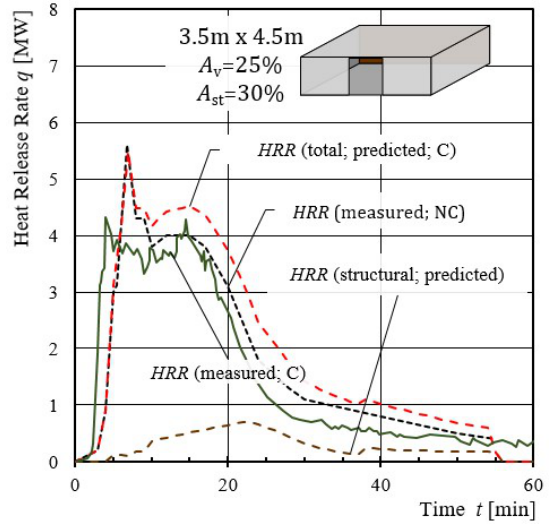
Figure 14: Predicted and measured HRR for experiment III.